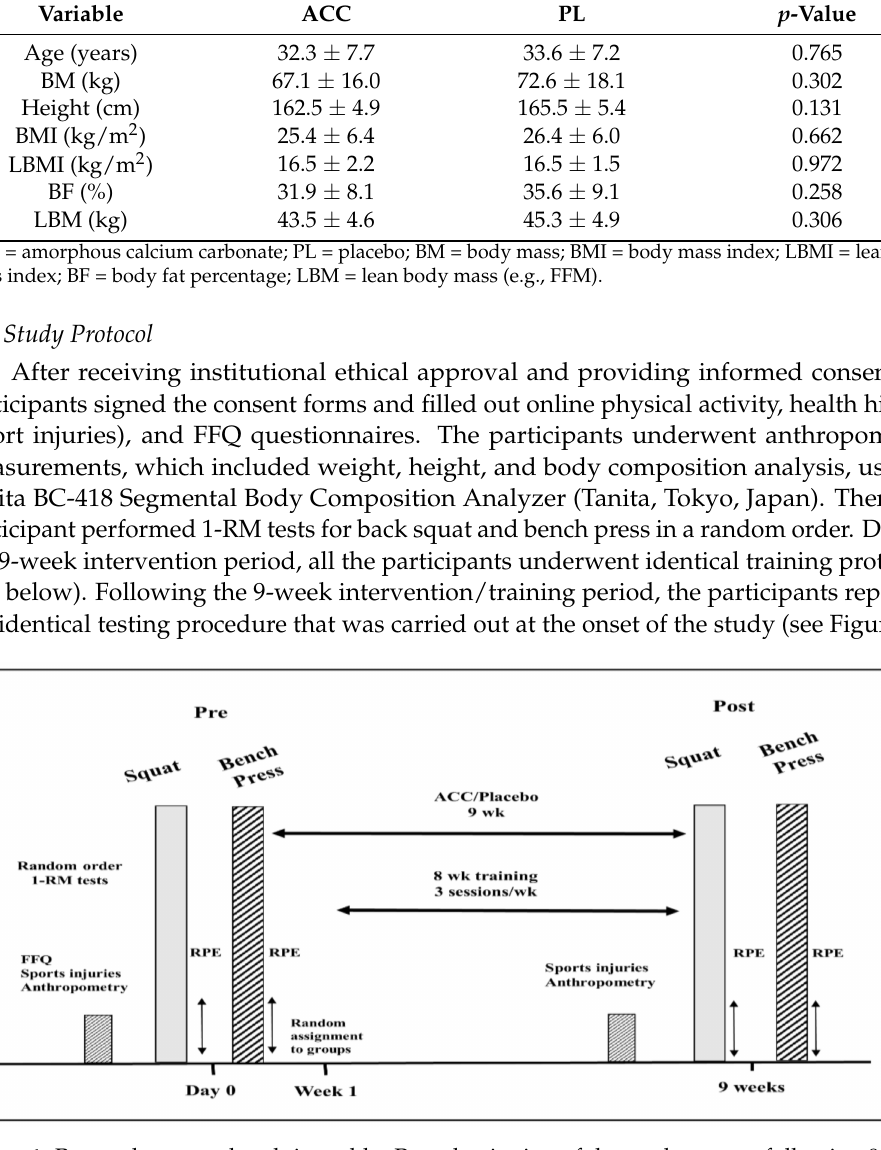
Figure 1. Research protocol and timetable. Pre = beginning of the study; post = following 9-week intervention period; FFQ = food frequency questionnaire; RPE = rate of perceived